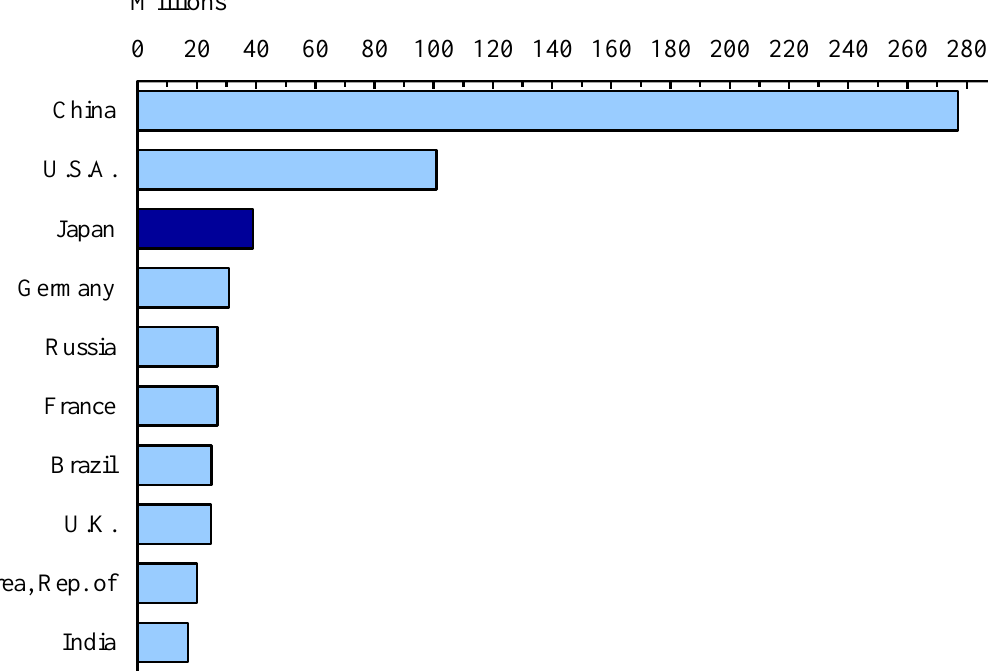
Source: International Telecommunication